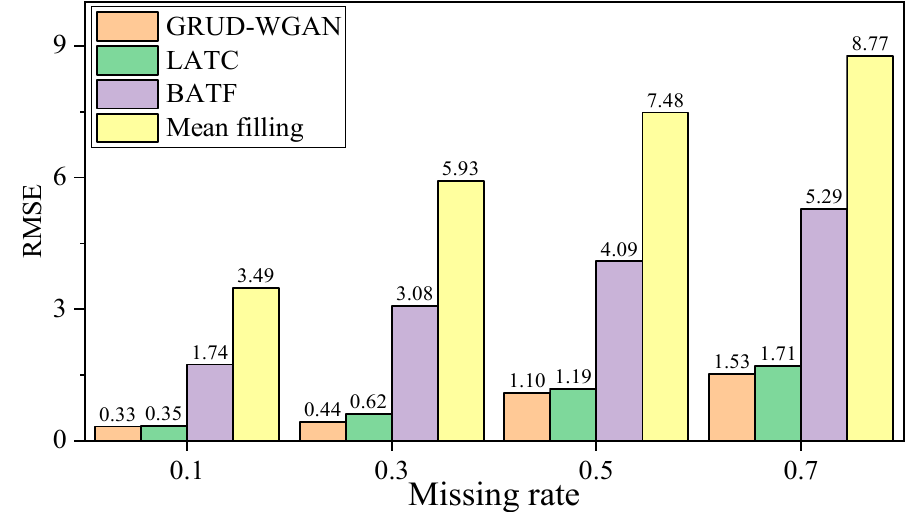
Figure 19. RMSEs of different data imputation models.